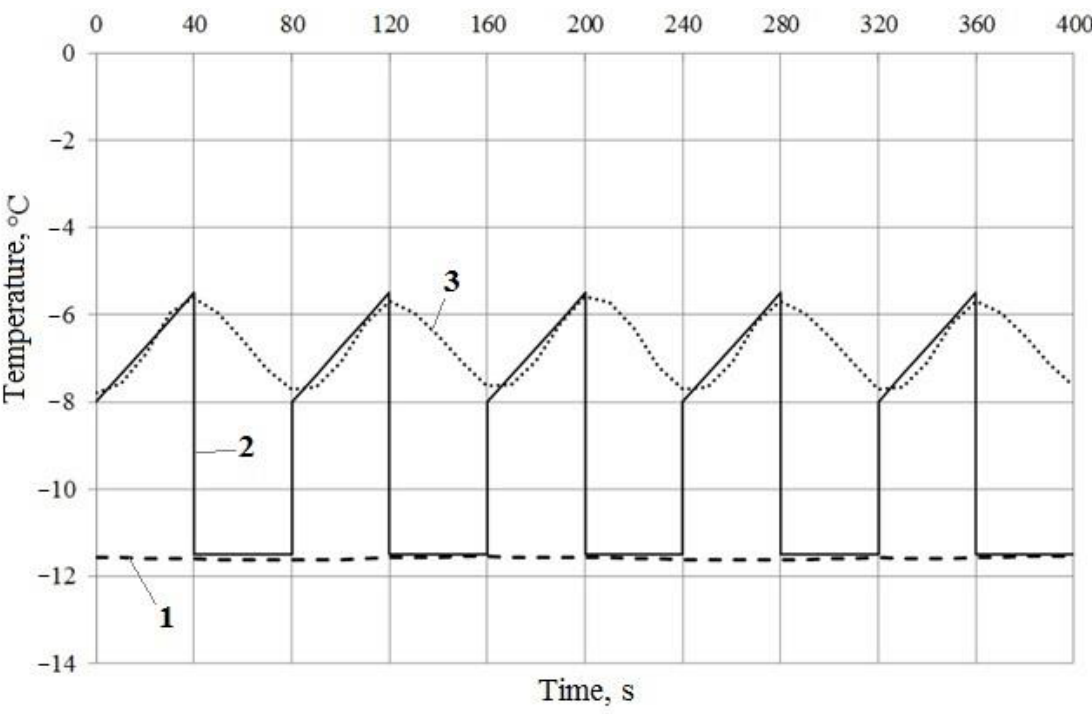
Figure 9. Comparison of experimental and calculated data on the change in air temperature at the outer end of the SSRHE: 1— T out , 2—calculation, 3—experiment.